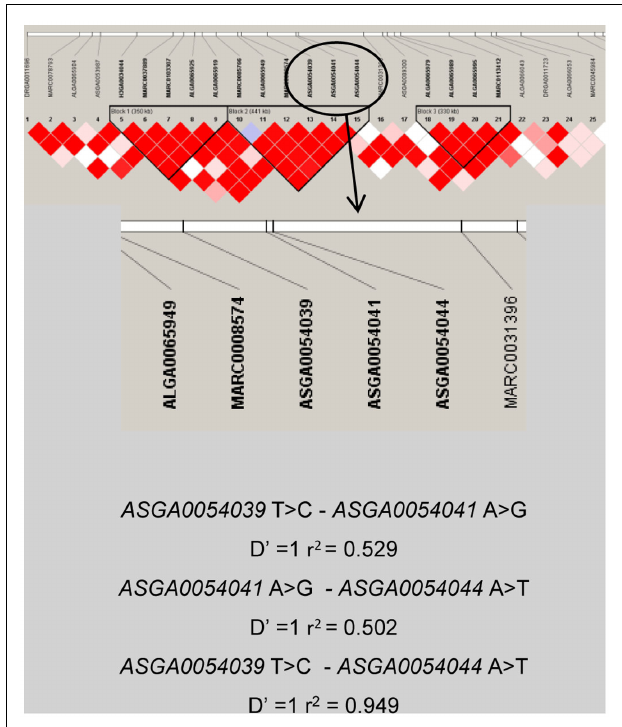
FIGURE 5 | Haplotype diagram of the region located between 59.4 and 61.29cM. Description of linkage block of PCTP SNPs ( ASGA 0054039T >